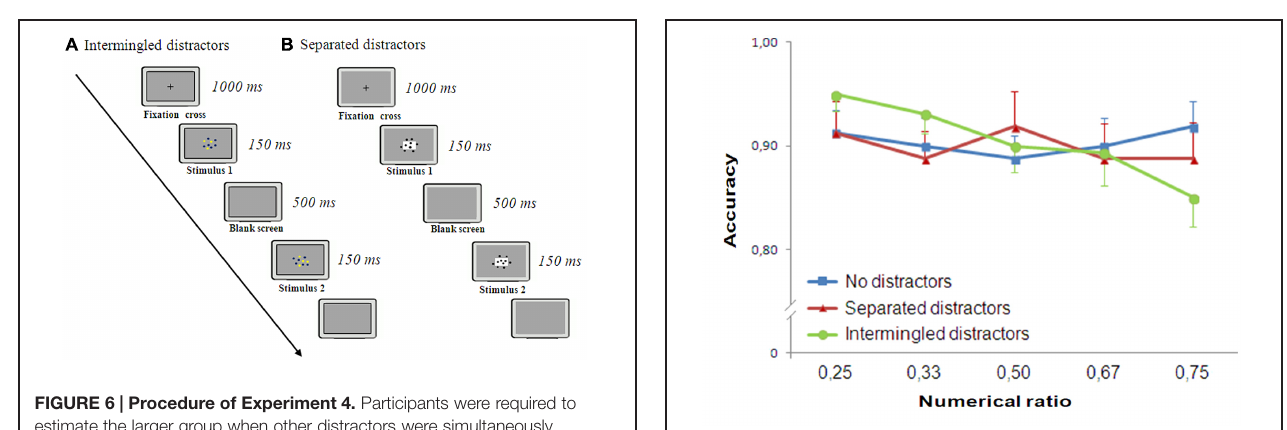
FIGURE 7 | Results of Experiment 4. Participants’ accuracy showed ratio dependence when distractors were mixed together to the target stimuli. In contrast when no distractors were presented (control group) or when distractors were separated from the target stimuli, ratio dependence was not